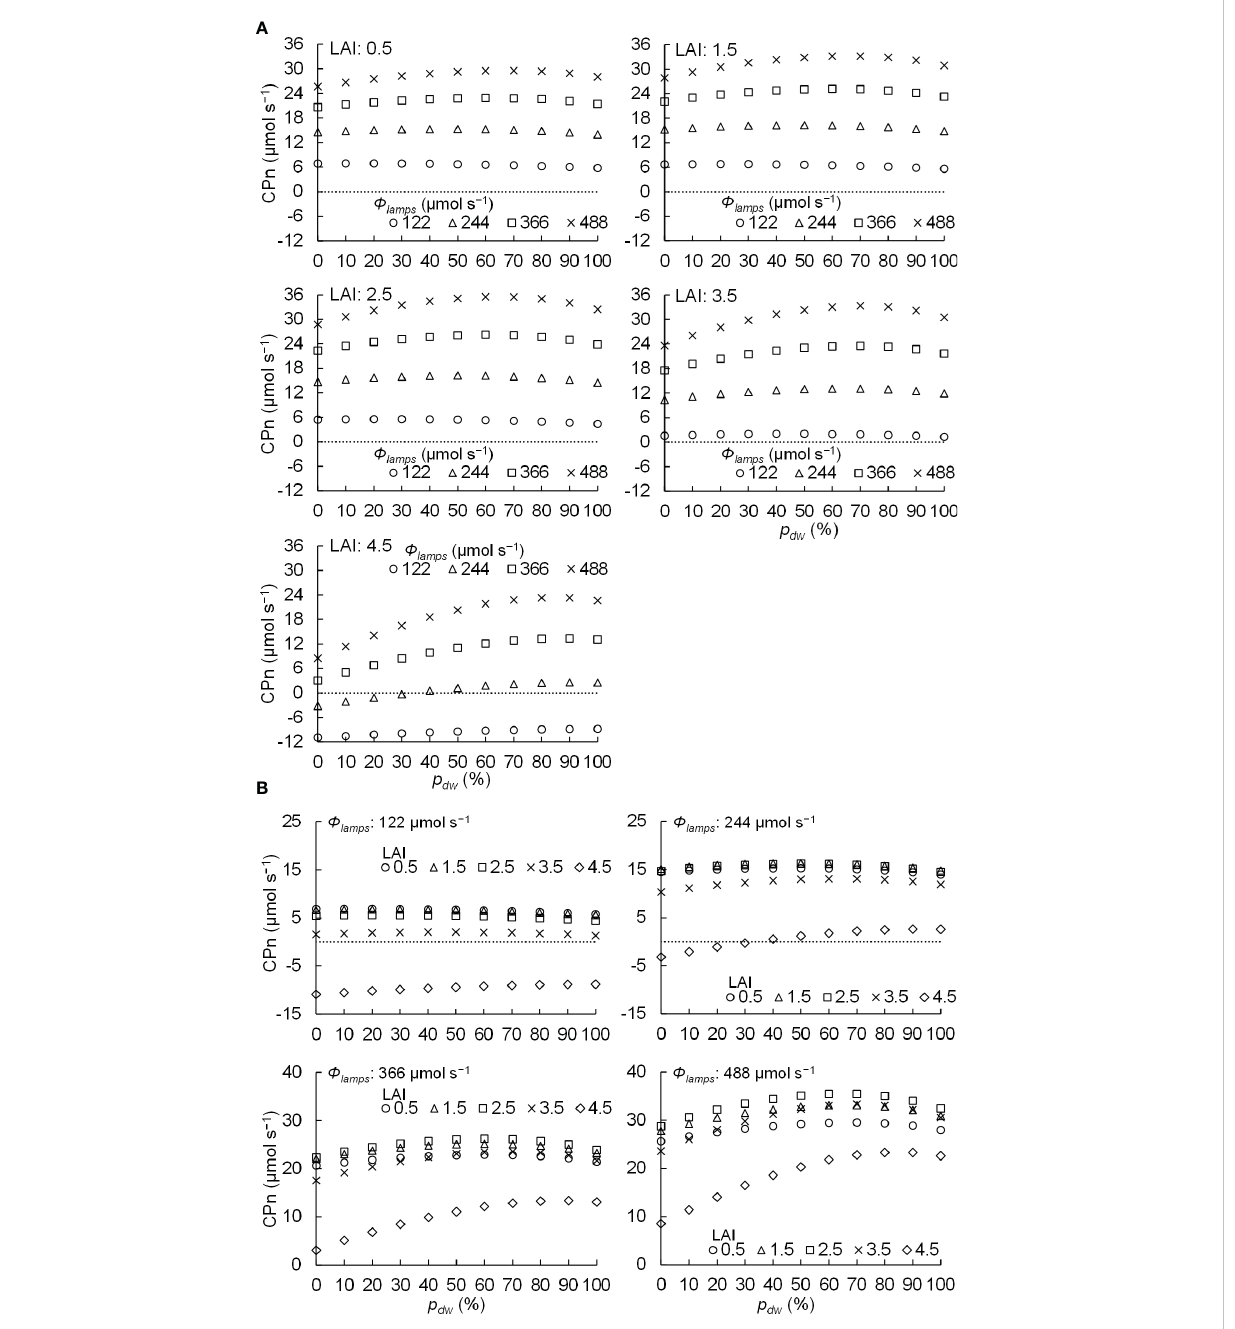
FIGURE 9 Relationship between the proportion ( p dw ) of the photosynthetic photon fl ux of lamps for downward lighting to that of whole lamps for downward and upward lighting ( F lamps ) and the net photosynthetic rates of the komatsuna canopy (CPn) in different conditions of leaf area index (LAI) (A) and F lamps (B)